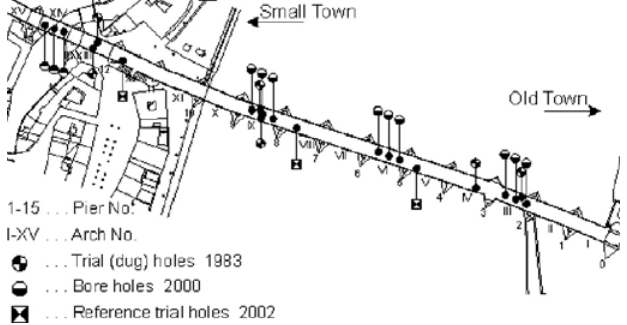
Fig 5. A scheme of test hole positioning in Charles Brid- ge body (1983, 2000, 2002)